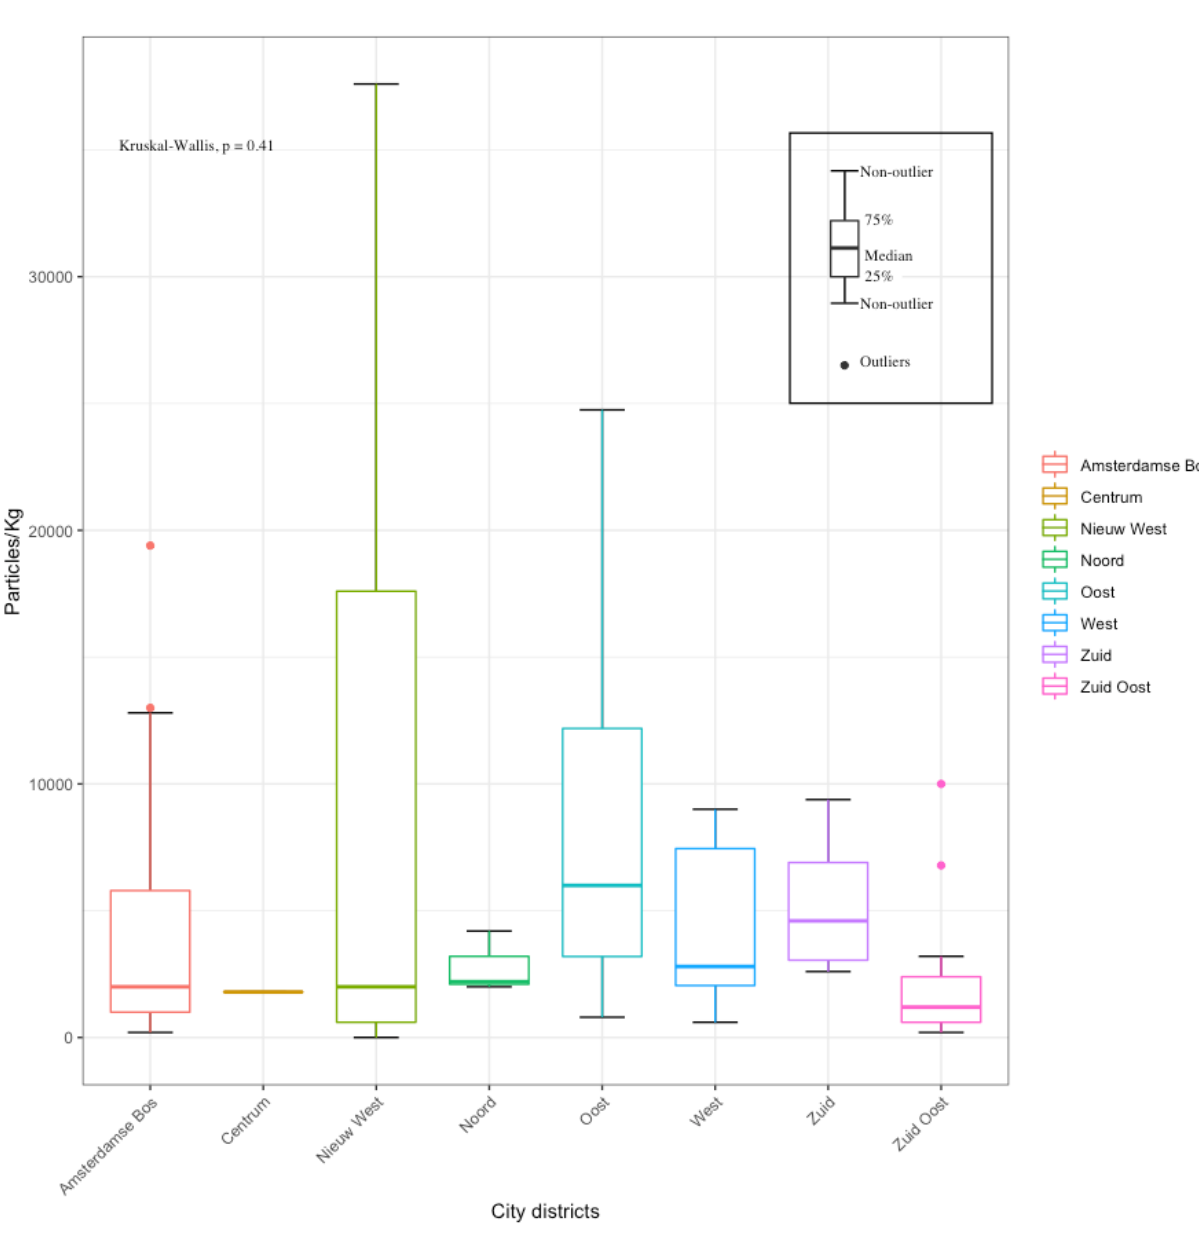
Figure 2. Visualization of microplastic concentrations (MPP Kg − 1 ) in soils from parks and recreational areas (n = 74) by city district in Amsterdam.